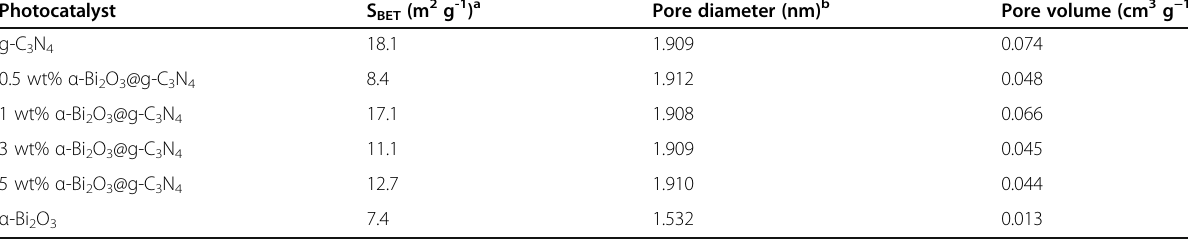
a BET specific surface area; b pore diameter calculated from the desorption branch of the isotherm using the BJH method; c total pore volume measured at P/P =